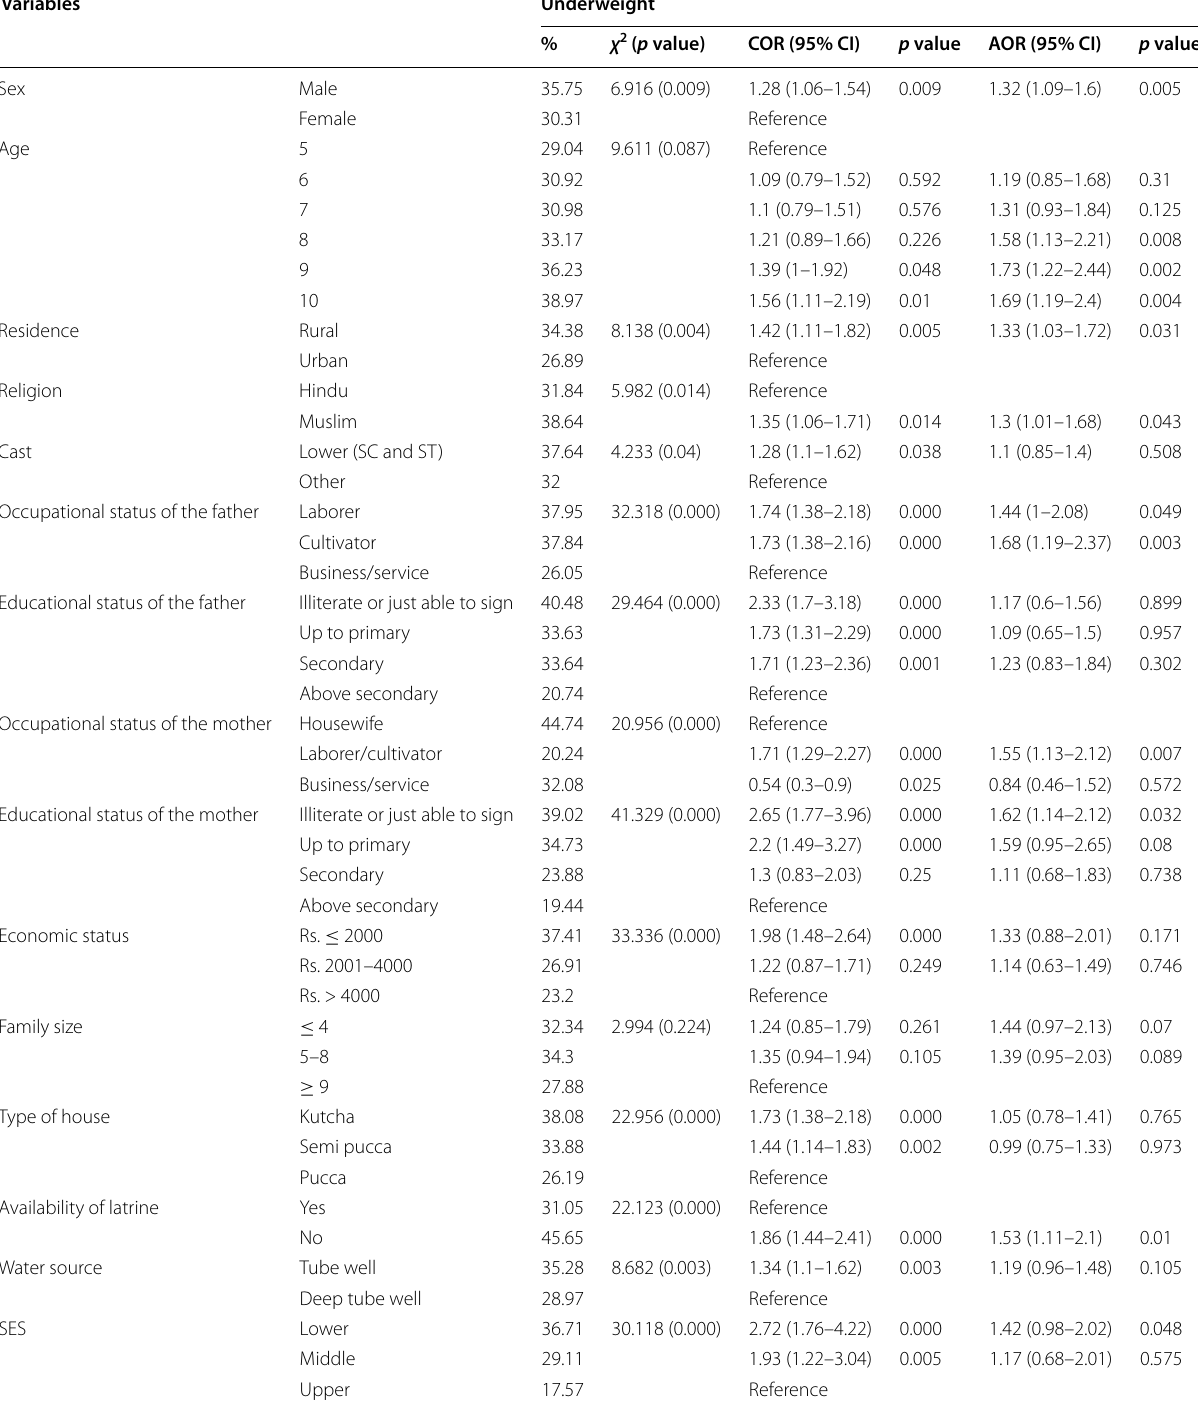
Table 4 Factors associated with underweight among children aged 5–10 years